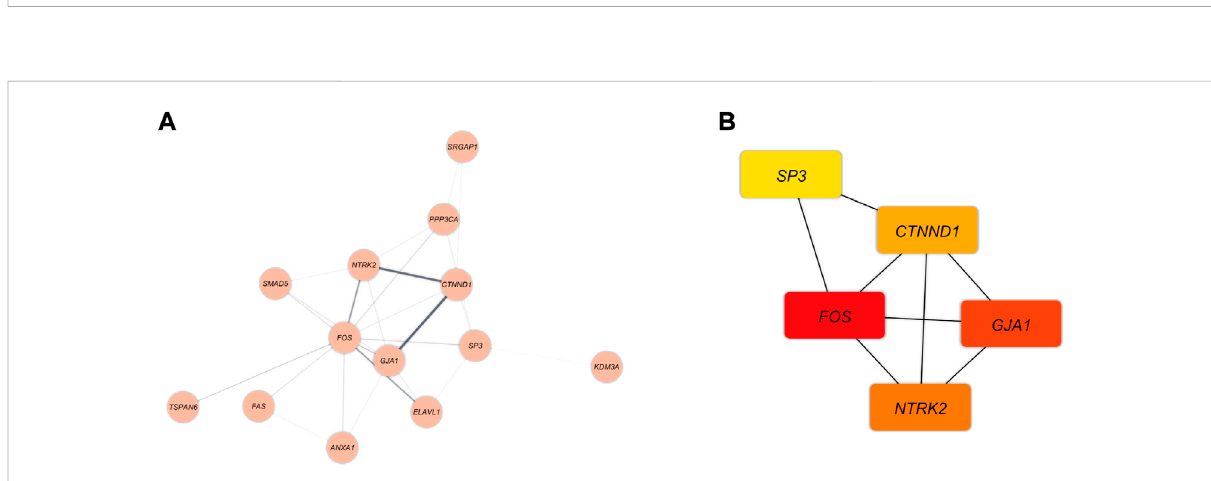
FIGURE 6 (A) The DEmRNAs interactions are shown as blue nodes in this PPI network. (B) The recognized hub genes in the PPI network. The yellow, orange, and red nodes, respectively, represent hub genes with weak, moderate, and strong